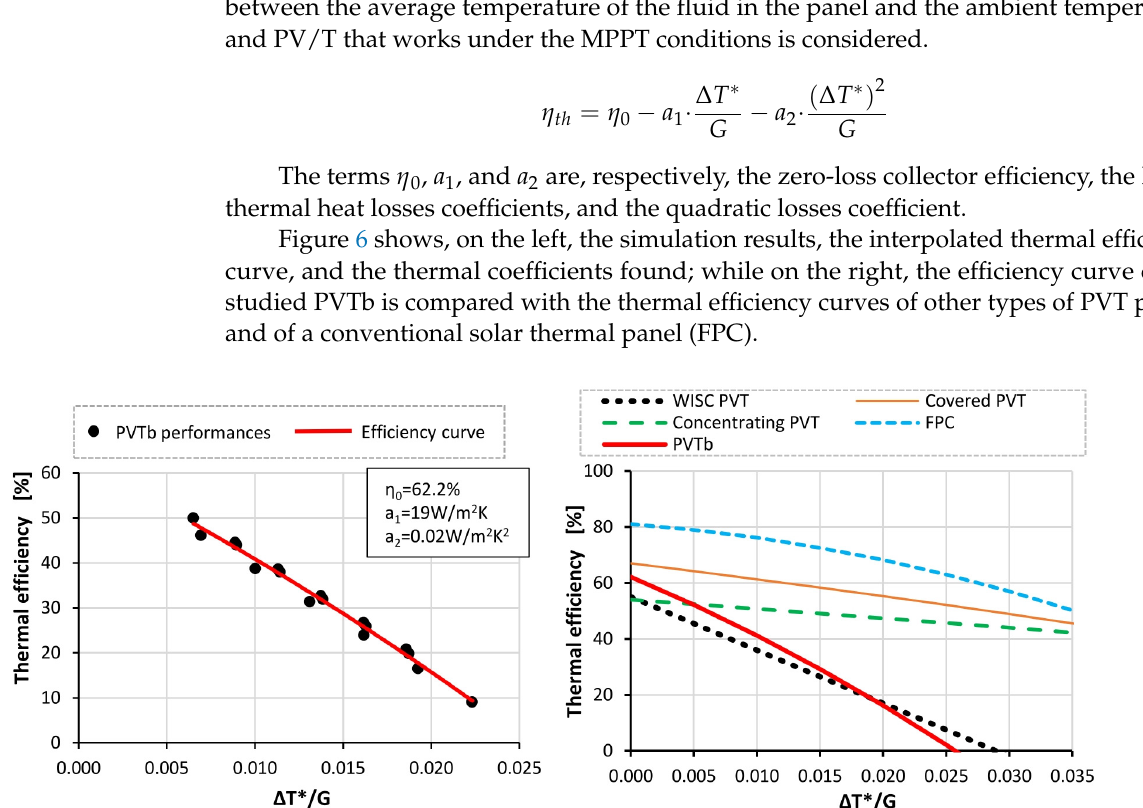
Figure 7. Weather data during summer and winter solstice. A constant wind speed of 1.0 m/s is used for all the investigated scenarios. Following the outcomes of the previous section, the numerical simulation is carried out adopting a specific airflow rate of 0.0075 kg/(s ∙ m 2 ), and 0.008 kg/(s ∙ m 2 ) for the liquid flow rate.